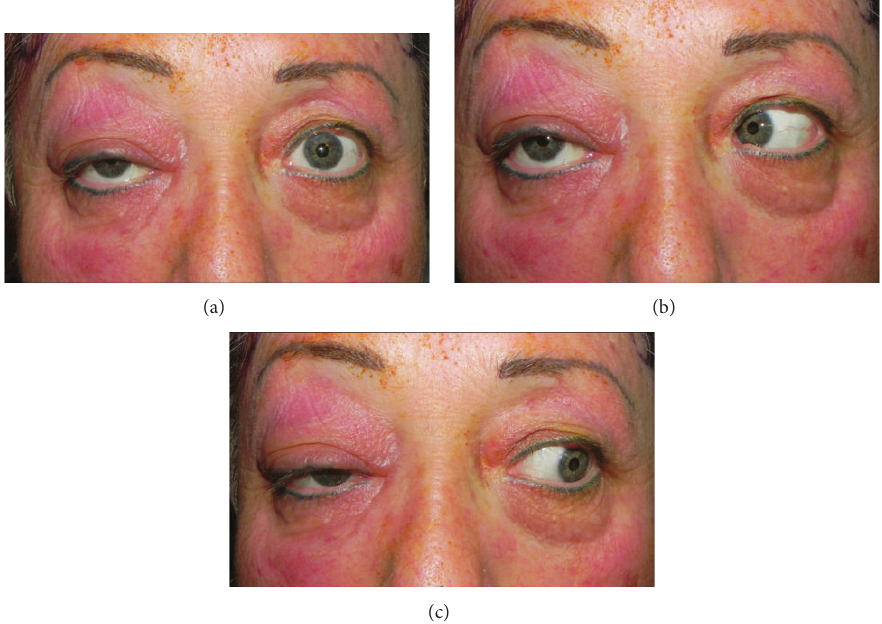
Figure 2: Clinical photograph showing right eye limitation of abduction and